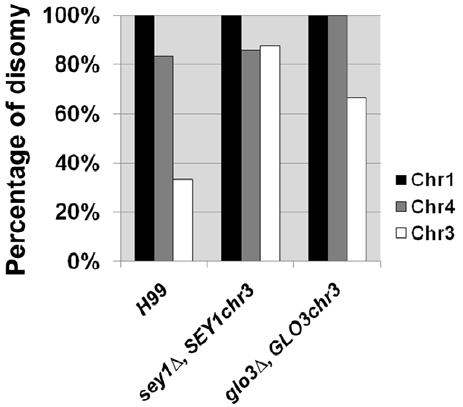
Figure 4. Frequency of Chr3 disomy is increased in the strains with SEY1 and GLO3 translocation to Chr3. The wild type genes SEY1 and GLO3 were each inserted into Chr3 of the respective deletant strains sey1 D and glo3 D . 6–8 resistance clones grown at 3LHF were analyzed for copy number of the genes specific to each chromosome. Each bar represents the frequency of disomy formation in each chromosome.